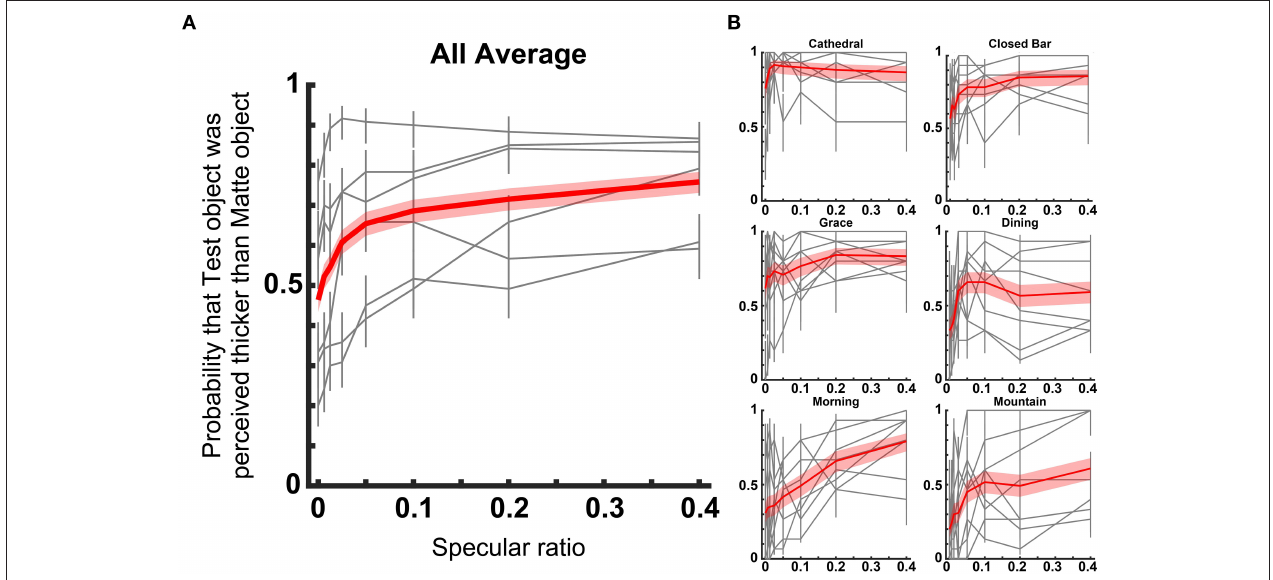
FIGURE 3 | Perceived thickness for different light probes. (A) Plots show mean probability that the test object with each specular ratio was perceived thicker than the Matte reference object. The red line shows the average across all light probes and observers. Gray lines show the result for each light probe [shown in (B) as a red line]. The red band and gray error bar show the 95% confidence interval. (B) Results are shown separately for different light probes. The red line shows the average of all observers. Gray lines show the result of each observer. The red band and gray error bar show the 95% confidential interval.